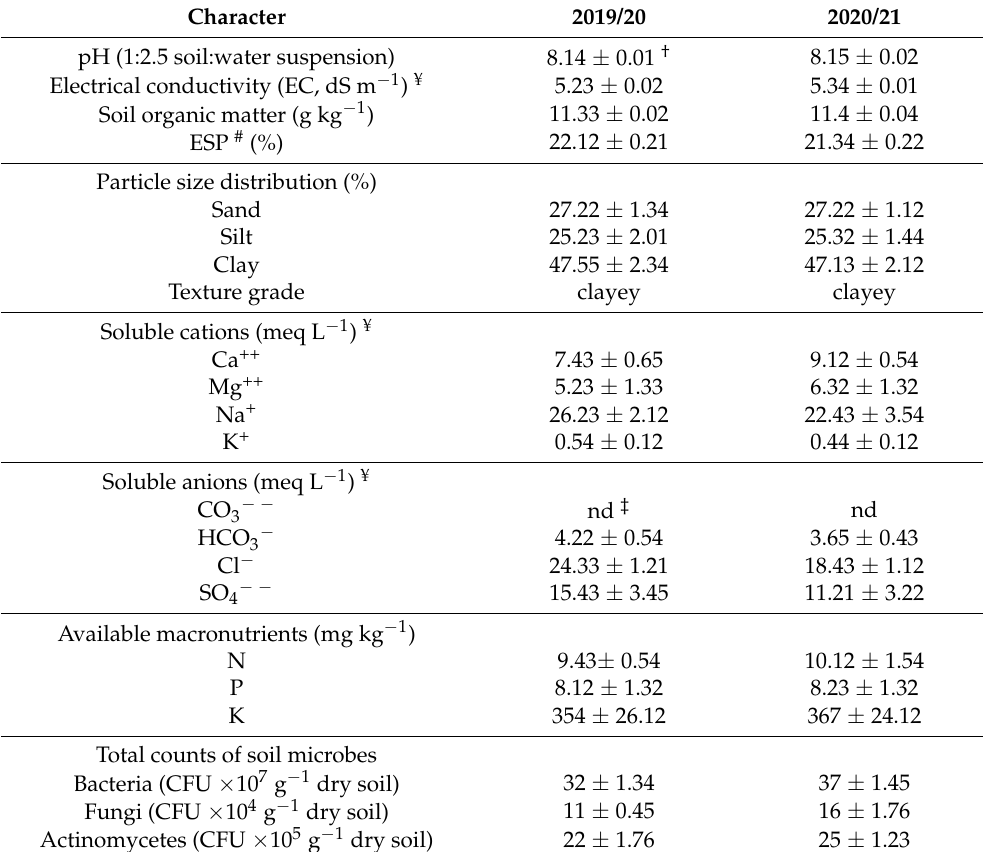
Table 6. Physicochemical characteristics of the experimental soil (0–30 cm depth) in the two growing seasons 2018 and